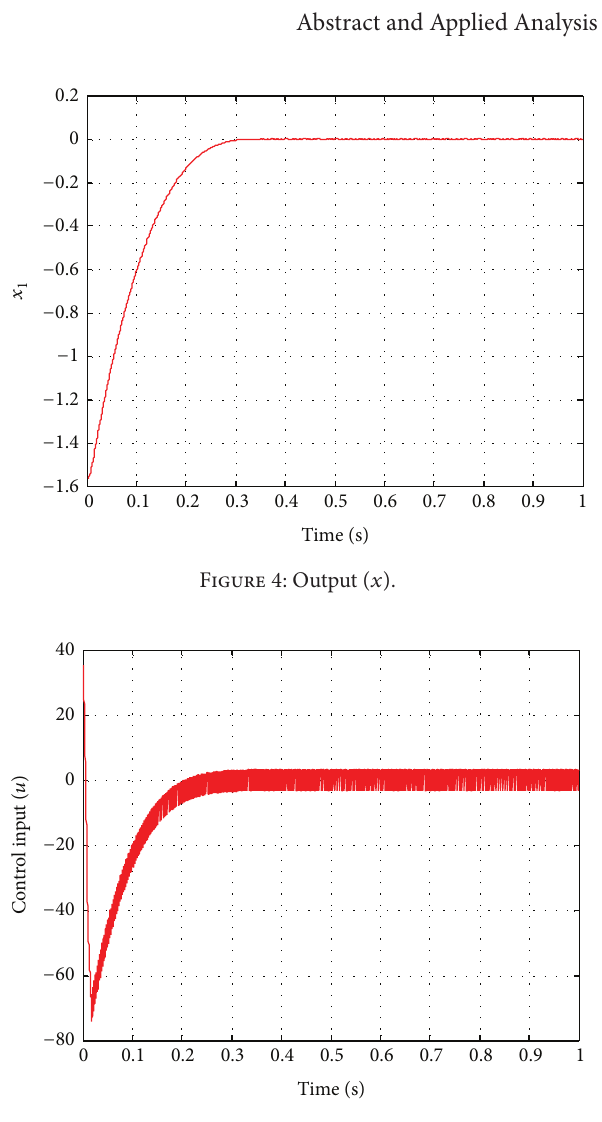
Figure 5: Control input ( 𝑢 ) for signum